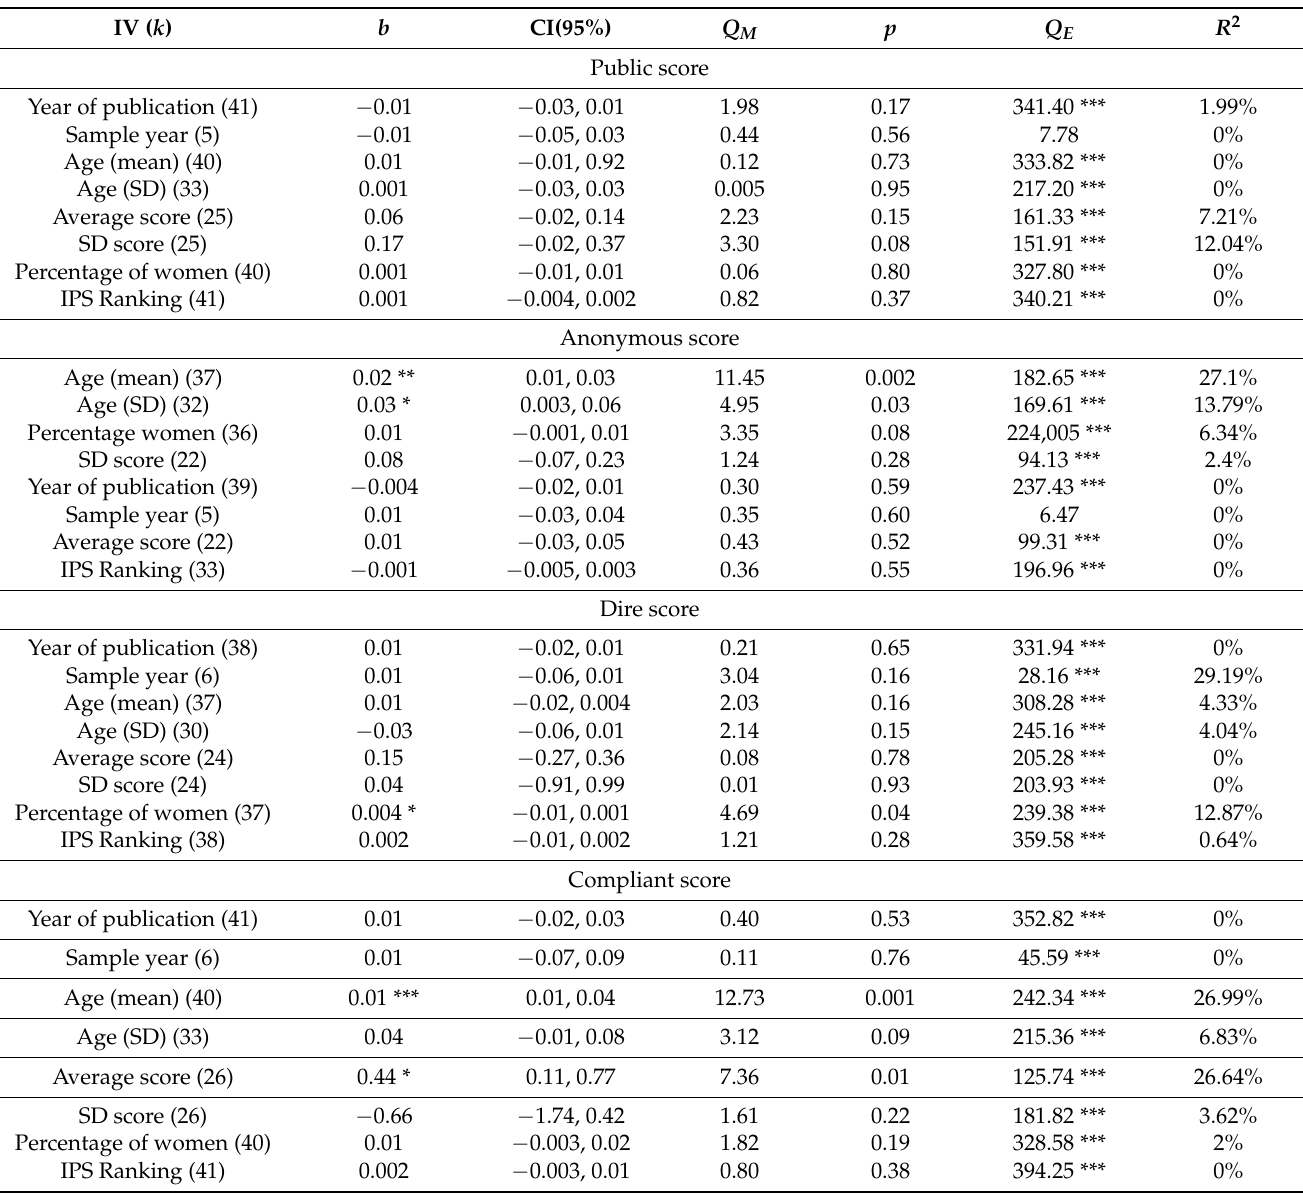
Table 3. Analysis of continuous moderating